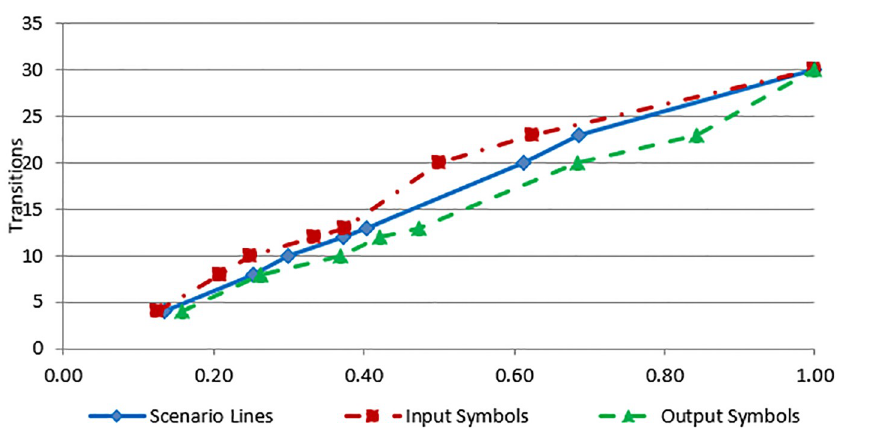
Fig 15. Kripke structure transitions to use case